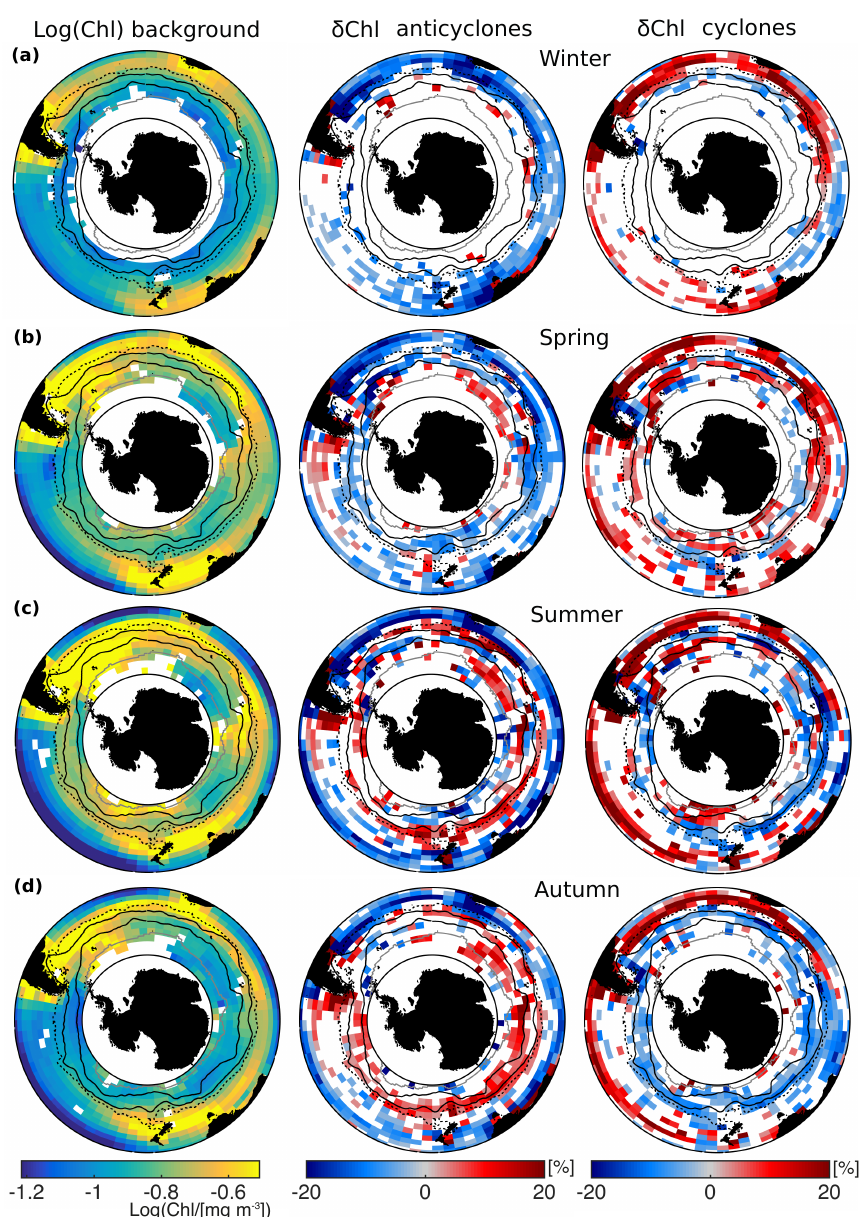
Figure 3. Seasonality of chlorophyll anomalies ( δ Chl) associated with eddies; austral (a) winter (JJA), (b) spring (SON), (c) summer (DJF), and (d) autumn (MAM) for anticyclones (middle) and cyclones (right); The logarithm (base 10) of seasonal climatological Chl is shown for reference (left). Otherwise the same as Fig.